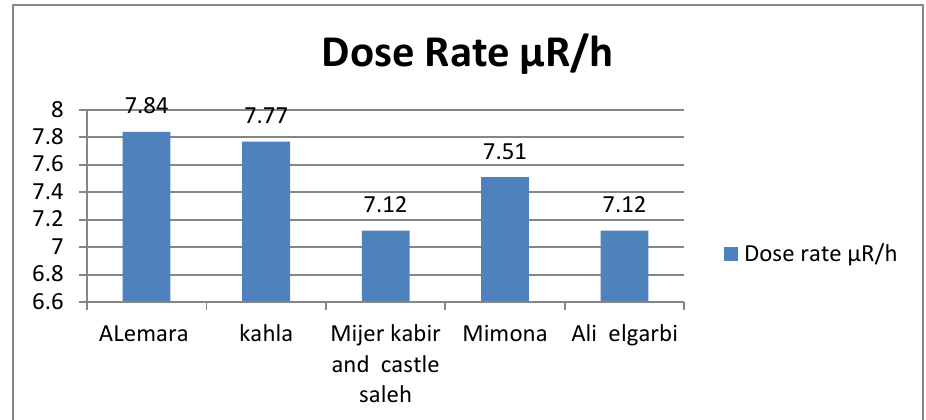
Fig. 6: The radiation dose rates for the elected positions in the province of Missan by GR-460 system.